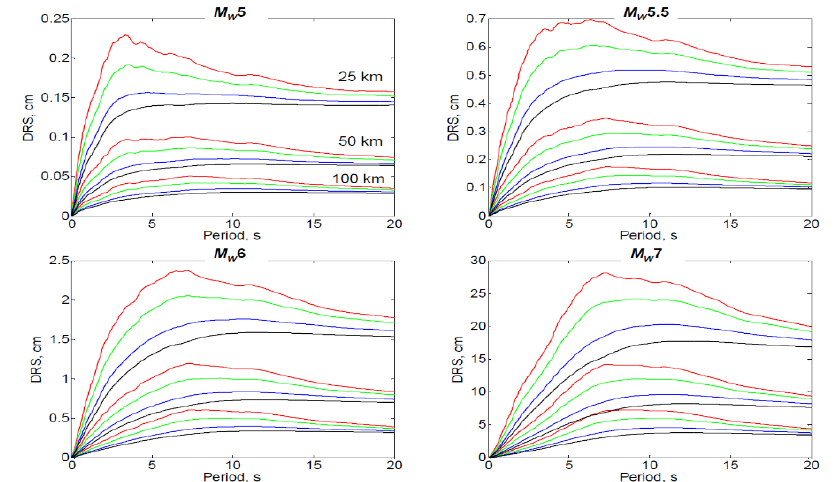
Figure 23. Displacement spectra of rock sites for different M w , focal distance, and damping [78] .